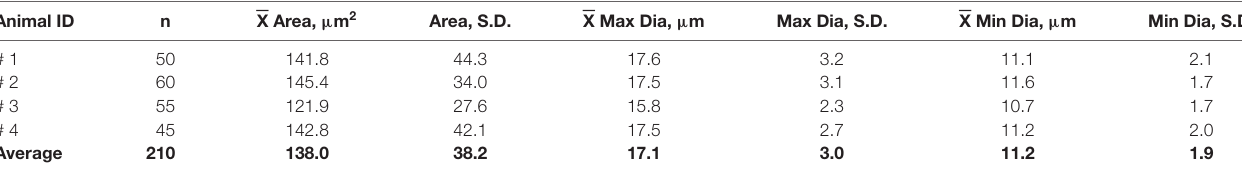
*Standard Error. Bold values represent averages. TABLE 2 | Average ( ± S.D.) cell body cross-sectional areas and their maximum and minimum diameters of EVN neurons labeled with GFP/ChAT. Animal ID n (cid:83) X Area, µ m 2 Area,